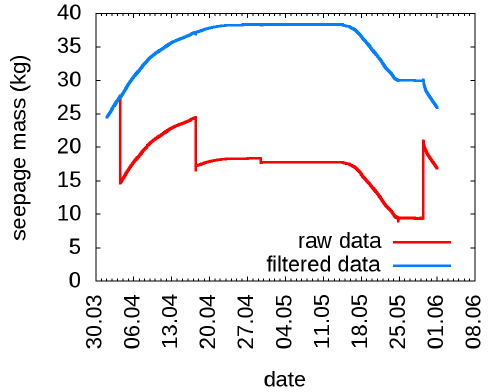
Figure 13. Comparison of processed and raw seepage mass data for the lysimeter